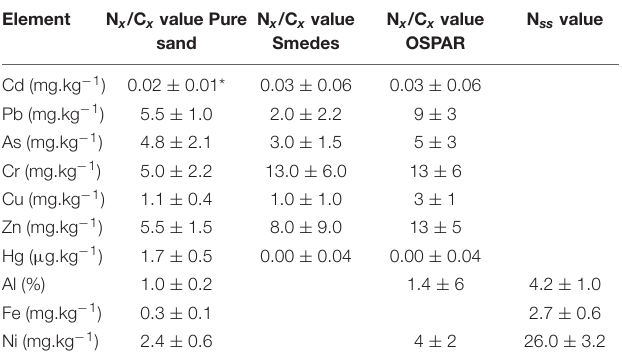
TABLE 3 | Pivot values (Nx/Cx) and standard seafloor concentrations (Nss) with respective standard deviations, and compared to values presented in Smedes et al. (1997) and OSPAR (2008).